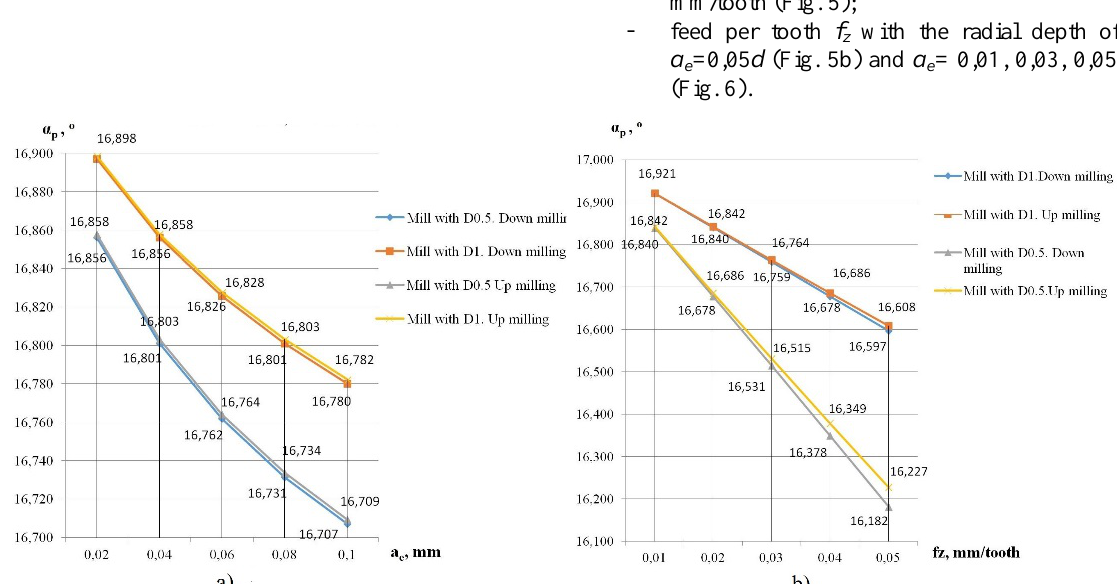
Fig. 4 . Dependencies of the kinematic clearance angle α р for micro end mills with d =1mm and d =0.5mm both having clearance angle α =17 о on: a) radial depth of cut a e with feed per tooth f z =0.05 d ; b) feed per tooth f z with radial depth of cut a e =0.05d